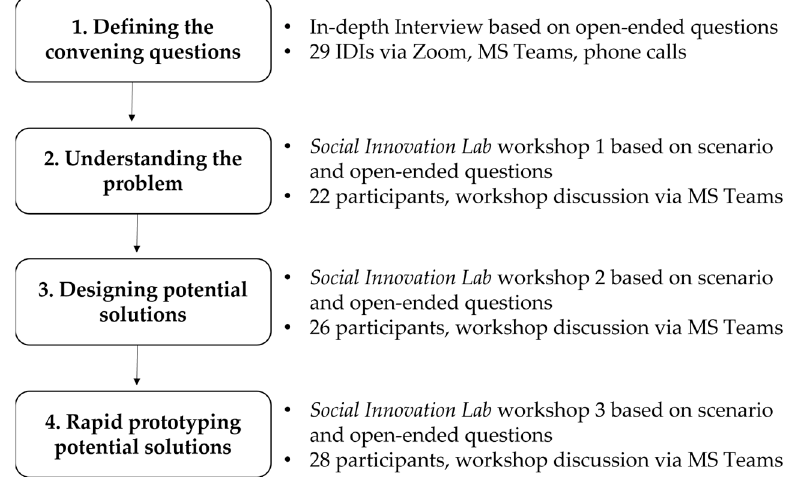
Figure 1. Characteristics of the research phases and methods. Source: own elaboration.